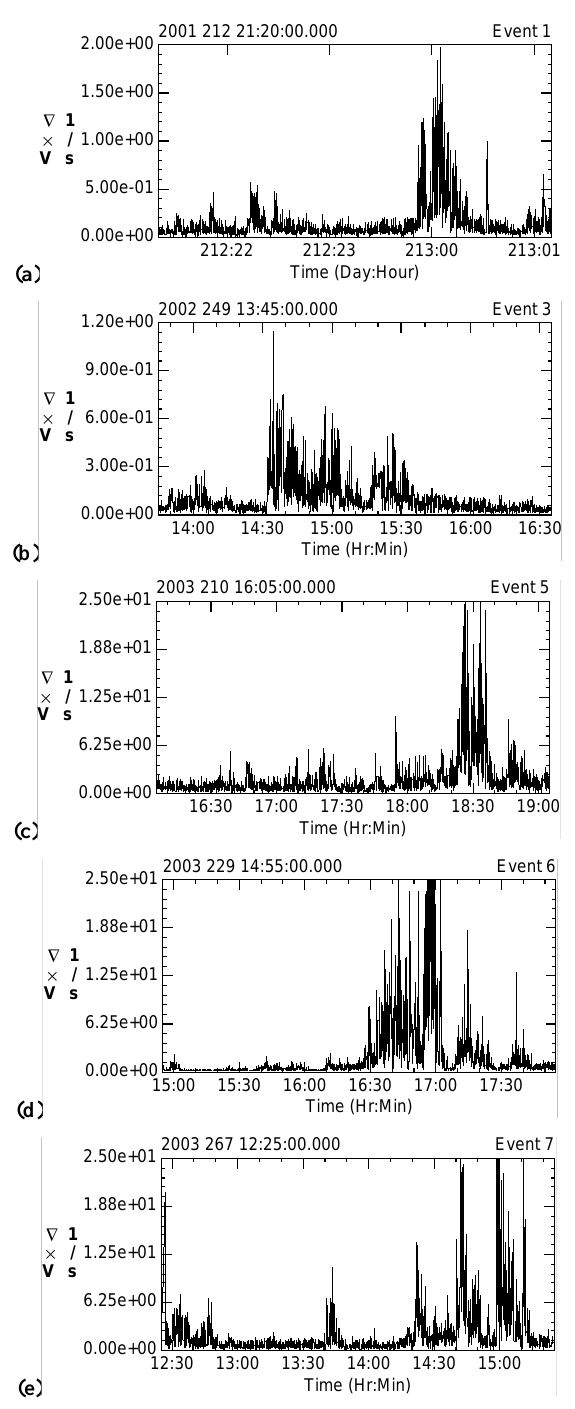
Fig. 3. Plots of the magnitude of the vorticity for five of the inner plasma sheet crossing events listed in Table 1. The event numbers are given at the upper right of each plot. The plots show that vortic- ity is a common feature of the inner plasma sheet, often occurring in sets of multiple